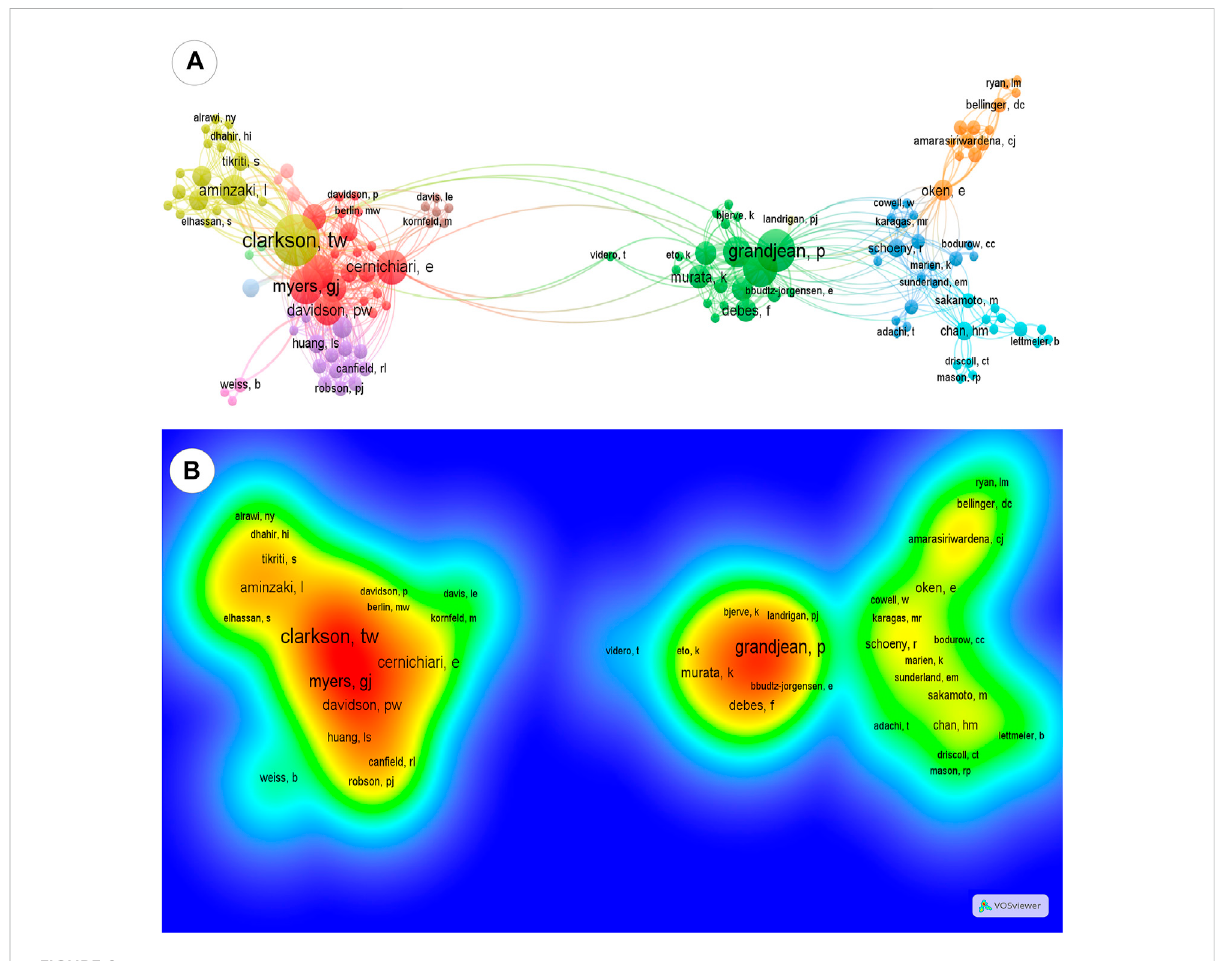
FIGURE 2 Network of co-authorship and density citation view of authors. (A) Network visualization of the top 100 most-cited papers about maternal exposure to MeHgand offspring health outcomes: samecolorsrepresentthesamecluster,andlinesbetweenclustersareco-citationlinksbetween the authors. The closer the authors are located to each other, the stronger their relatedness. (B) Density visualization: colors indicate the citation density of authors, ranging from blue (lowest density) to red (highest